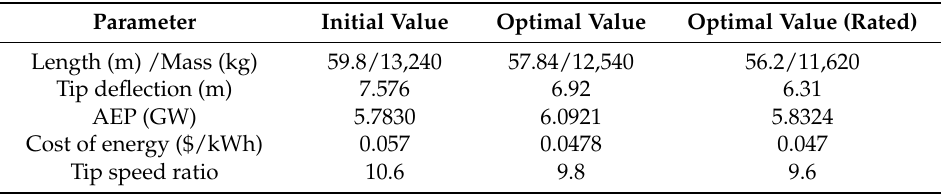
Table 5. Optimization design results of the blade.